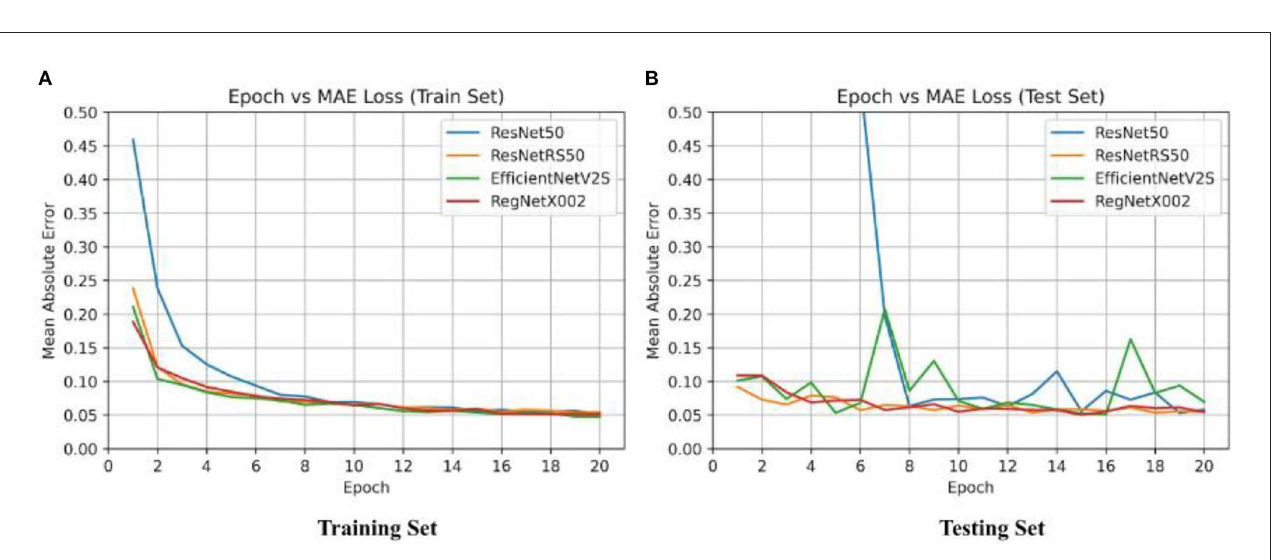
FIGURE4 Epoch vs. loss for training and testing sets of ResNet-50, ResNetRS-50, EfficientNetV2-S, and RegNet-X002. (A) Training set epoch vs. MAE. (B) Testing set epoch vs.